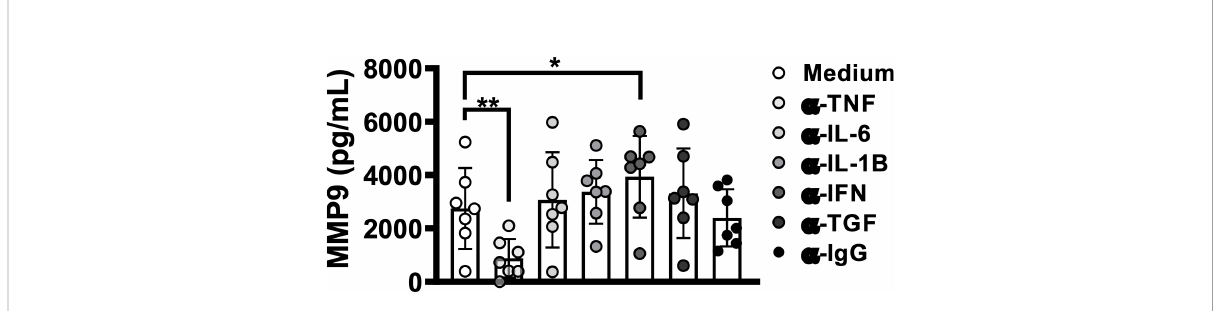
indicate a protective role for IFN- g , since the neutralization of this cytokine subsequently increased MMP-9 production in PBMC culture supernatants (Figure 4). Together, these fi ndings demonstrate that proviral load in fl uences proin fl ammatory response, which is linked to both the production of MMP-9 and HAM/TSP development.